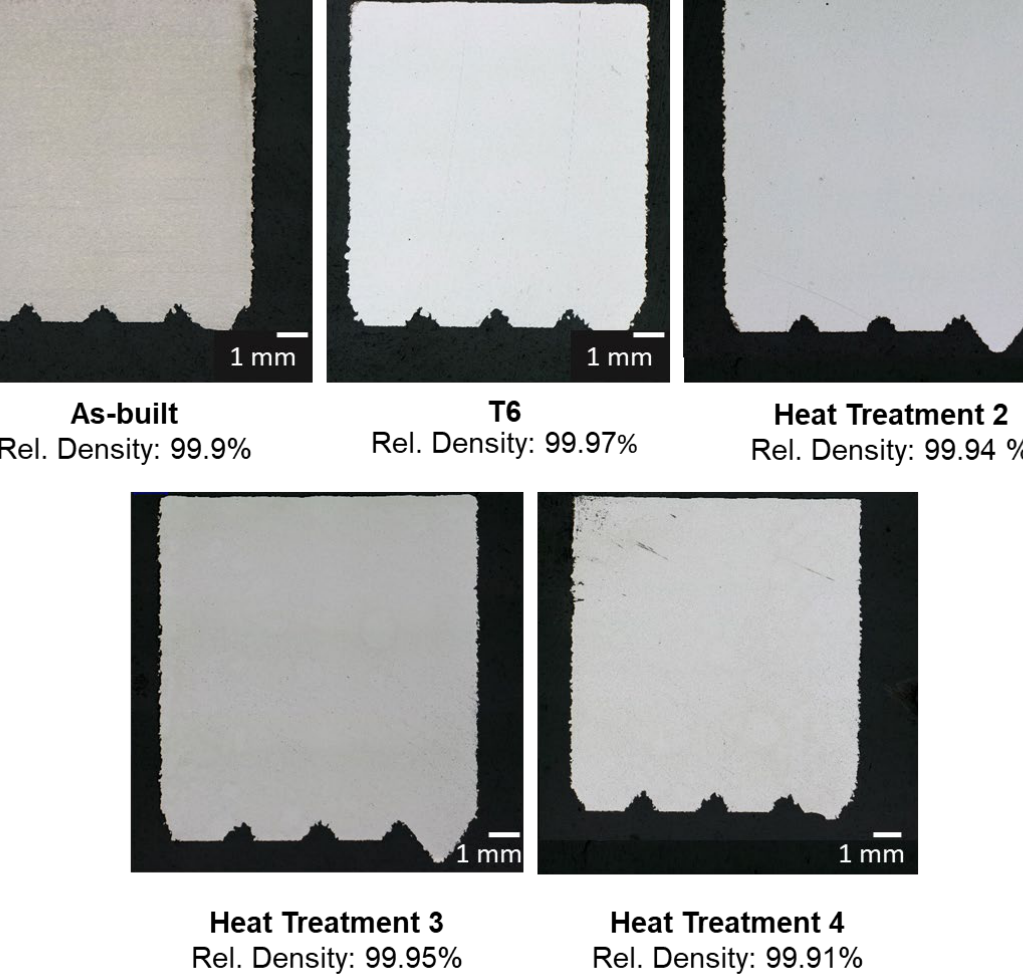
Figure 3. Images of cross-section with relative density measurement.